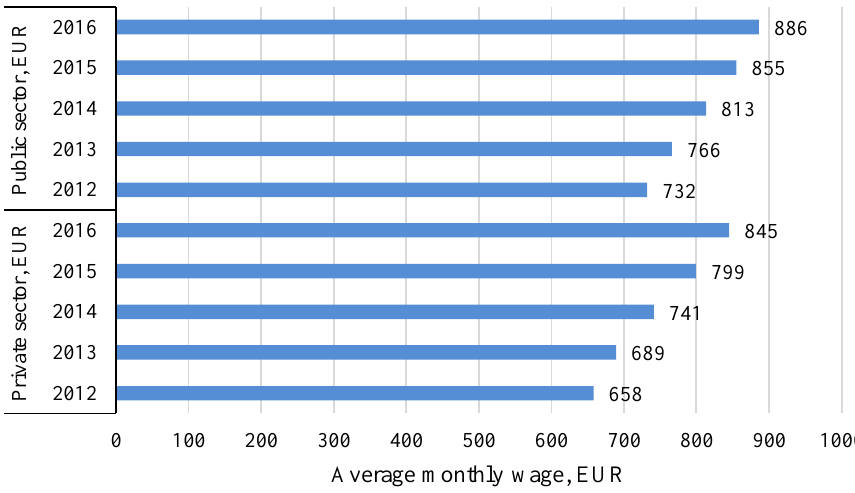
Fig. 2. Average monthly wage (gross, EUR) for the period of 2012–2016 in Latvia (Central Statistical Bureau, n.